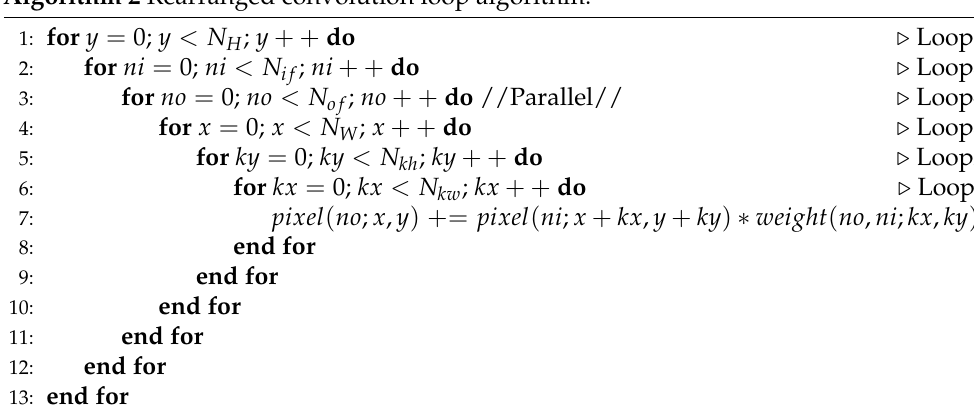
Algorithm 2 Rearranged convolution loop algorithm.